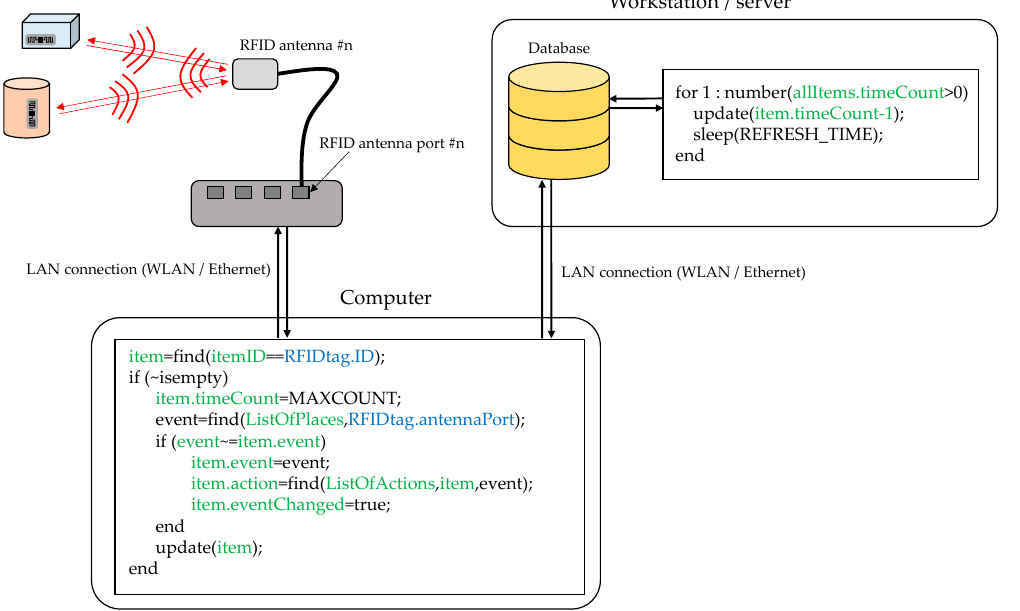
Figure 4. Scheme of the connection between the RFID antenna, the RFID reader, the computer controlling the RFID reader, and the system database. Pseudo-code illustrating how the database is updated every time a RFID tag is read is outlined (information associated to the database is highlighted in green, while inputs from RFID reader are highlighted in blue).